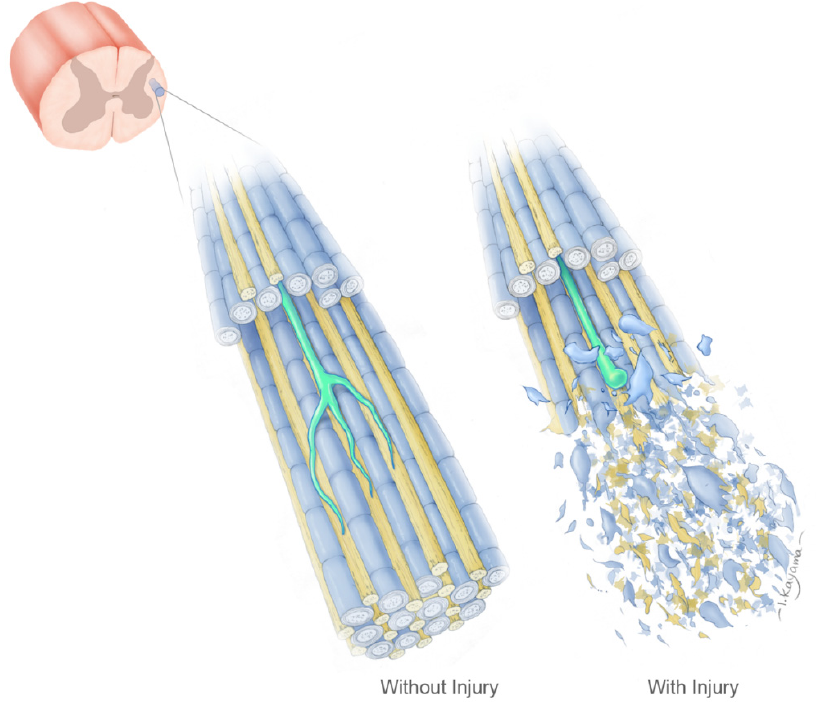
Figure 1. A representative sample of spinal cord white matter is shown in both intact ( left ) and injured ( right ) conditions. A growth cone (green) is shown advancing within a bundle of myelinated (blue) and unmyelinated (yellow) axons, although the latter could also represent any other permissive cellular elements within the tissue. The filopodia of the growth cone are shown advancing in association with the permissive elements but not along the myelinated axons, which present presumptive inhibitory factors. Following injury, the growth cone is no longer able to advance through the disrupted tissue due to loss of guidance from both the permissive and non-permissive tissue